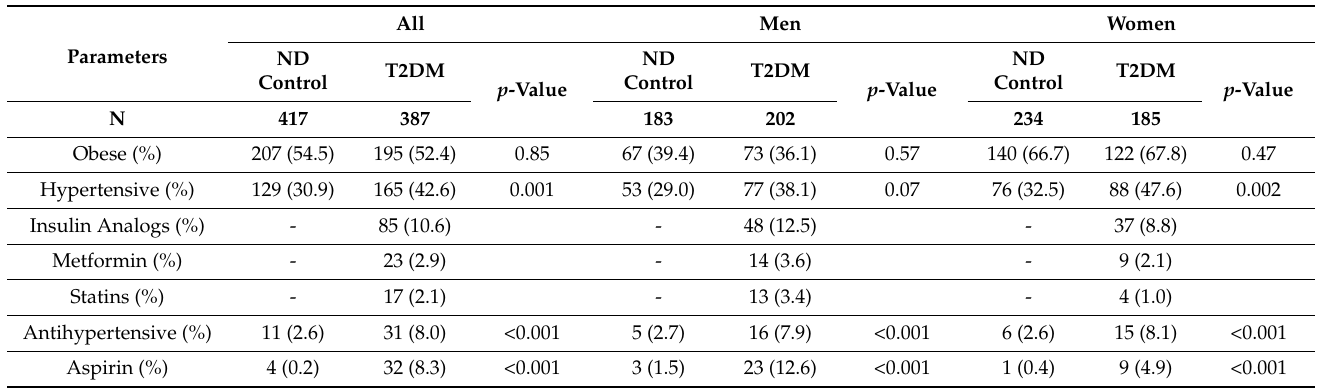
Table 1. Clinical characteristics of participants.